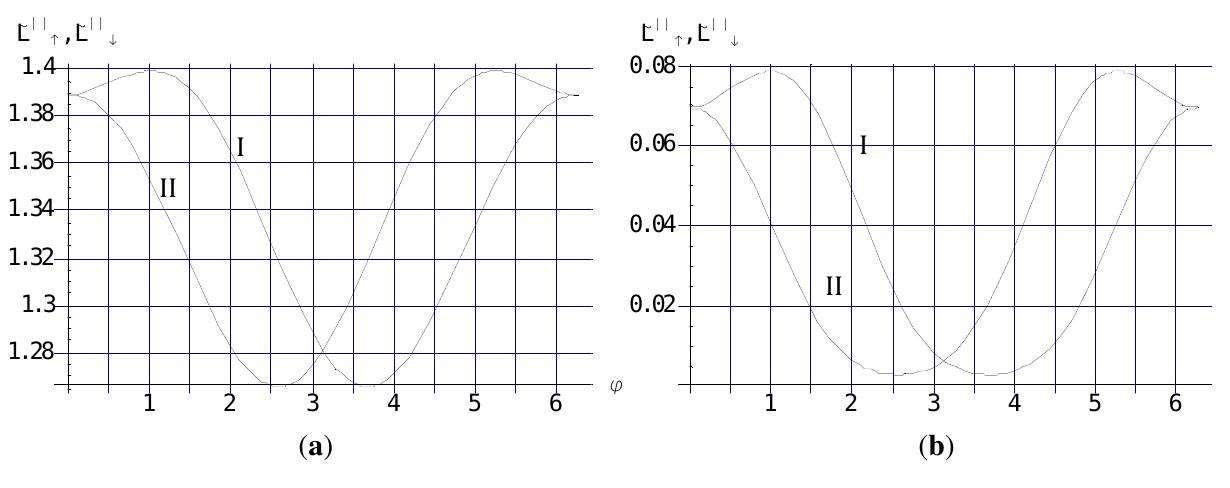
Figure 2. ˜ L (cid:107) (curve I) and ˜ L (cid:107) (curve II) versus ϕ (in radian). ( a ) for ka = 0 . 01 , and ( b ) for ↑ ↓ ka = 0 . 2 according to Equations (38) and